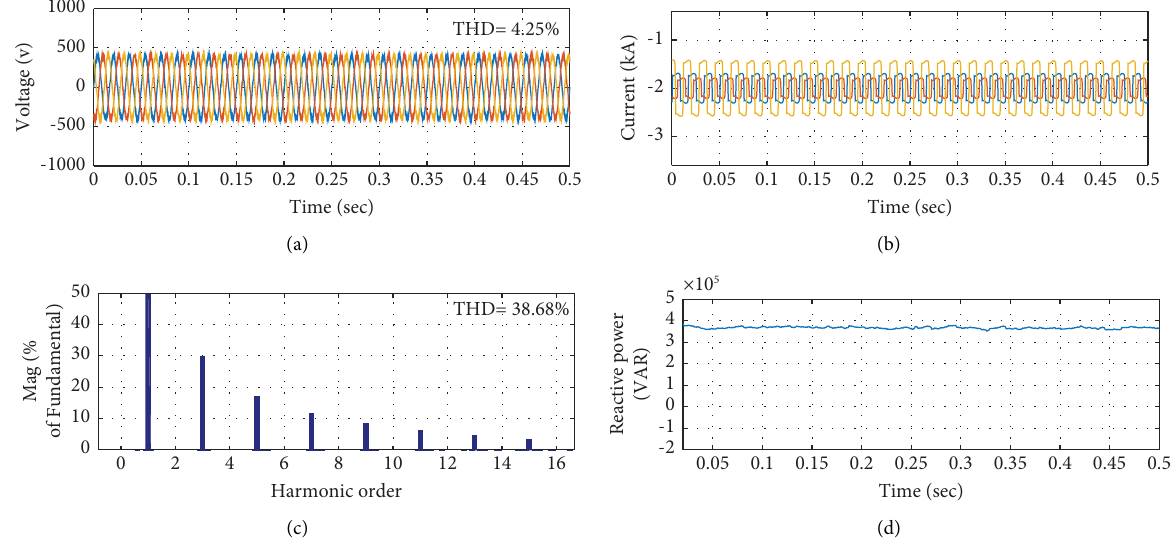
Figure 14: Performance during heavy nonlinear loading without SC-integrated APFs. (a) Load voltage waveform, (b) load current waveform, (c) FFT analysis of load current, and (d) reactive power of the